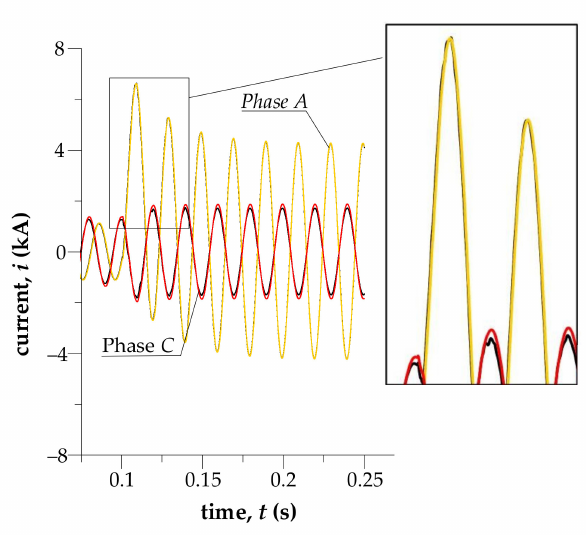
Figure 15. Temporal distributions of phase A and C current in the middle line